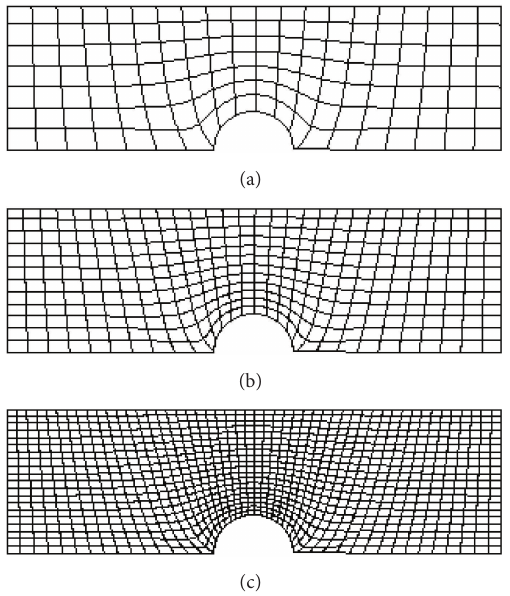
Figure 5: Description of the used grids: (a) has 70 × 200 points, (b) 120 × 300 points, and (c) 200 × 500 points; every 10th grid line is drawn.